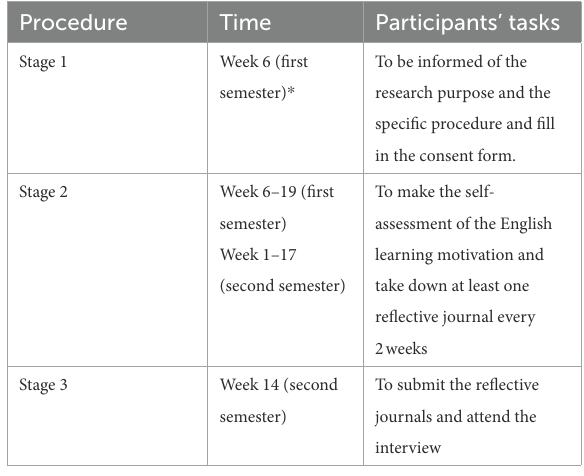
TABLE 1 Procedure of research